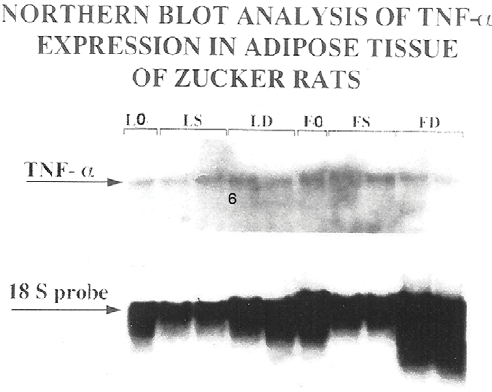
Figure 6. Northern blot analysis of TNF- a mRNA expression in the RWAT of lean and fa/fa rats. Northern hybridization of TNF- a mRNA and 18S ribosomal RNA (as control) was performed using the standard protocol. Briefly, total RNA from retroperitoneal WAT was extracted by Chomczynski method (Chomczynski 1993). Total RNA ( , 20 m g) was denatured and separated on formaldehyde gel. Lane 1, L0, lean-pretreatment at week 0; lanes 2 and 3, S-lean; lanes 4 and 5, CL- lean; lane 6, F0, fa/fa -pretreatment at week 0; lanes 7 and 8, S- fa/fa and lanes 9 and 10, CL- fa/fa rats.